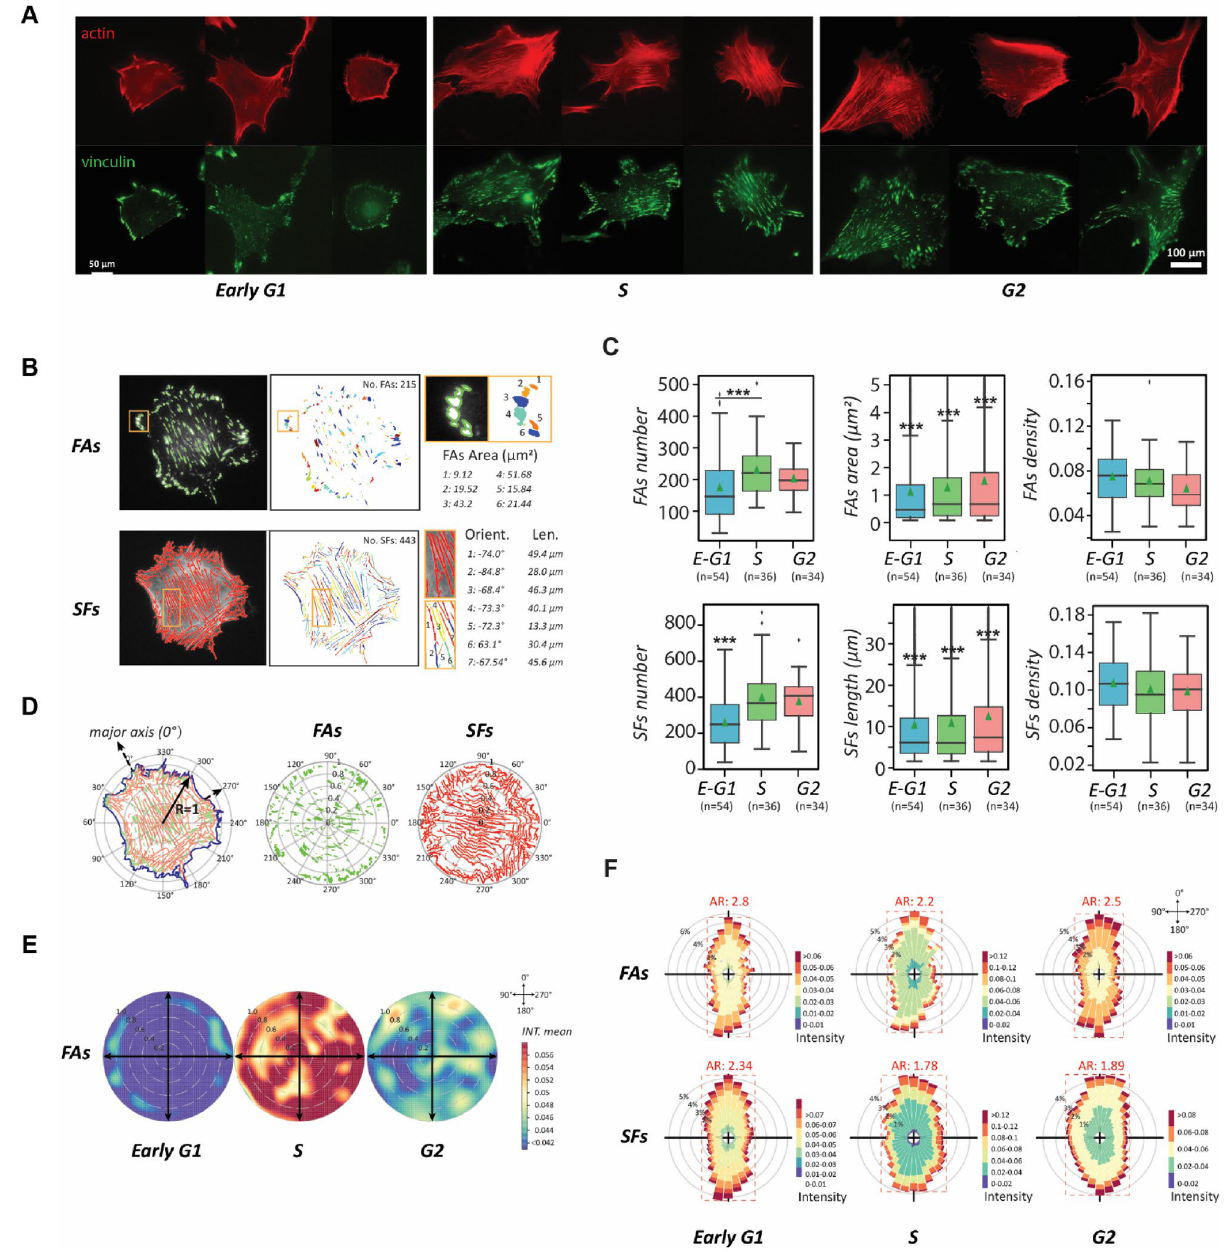
Figure 4. The transition of cell motility and polarity through the cytoskeletal remodeling over the cell cycle. ( A ) The cytoskeleton (actin; red) and adhesion plaques (vinculin; green) in NIH 3T3 fibroblasts over interphase of the cell cycle. Scale bar: 100 µm. ( B ) Segmented focal adhesions (FAs) and stress fibers (SFs) subjected to quantitative analysis using computer vision–left column: visualization of boundary segmentation of fluorescent cell images; middle: quantity of segmented FAs and SFs in single cells, shown in different colors; right: the quantification of FA and SF features, including size, length, and orientation. ( C ) Box plots presenting FAs and SFs dynamics during the cell cycle progression using the total number, single FAs area/SFs length, and density over the cell body. ( D ) The localization distribution of FAs in the cell normalized to a circle, where the distance to the centroid and the closest edge counts serve as the normalized position and the distribution is quantified by polar coordinates, in which cell centroid is set as the origin, and the 0° is aligned to the major axis. ( E ) Rose plots showing the distribution of FAs in each cell cycle stage at the cell population level. The degree of mean intensity is represented by warm (active)-cool (non-active) colormap. ( F ) Polar histogram plots showing the frequency localization of FAs (up) and SFs (down) of each stage of the cell cycle phases, where AR denotes the aspect ratio of the frequency distribution shape. The greater value of AR represents a more polarized FAs/SFs distribution. Data information: *** indicated that the group of data is statistically significant compared to other groups. The related statistical results of this figure are listed in Supplementary Table